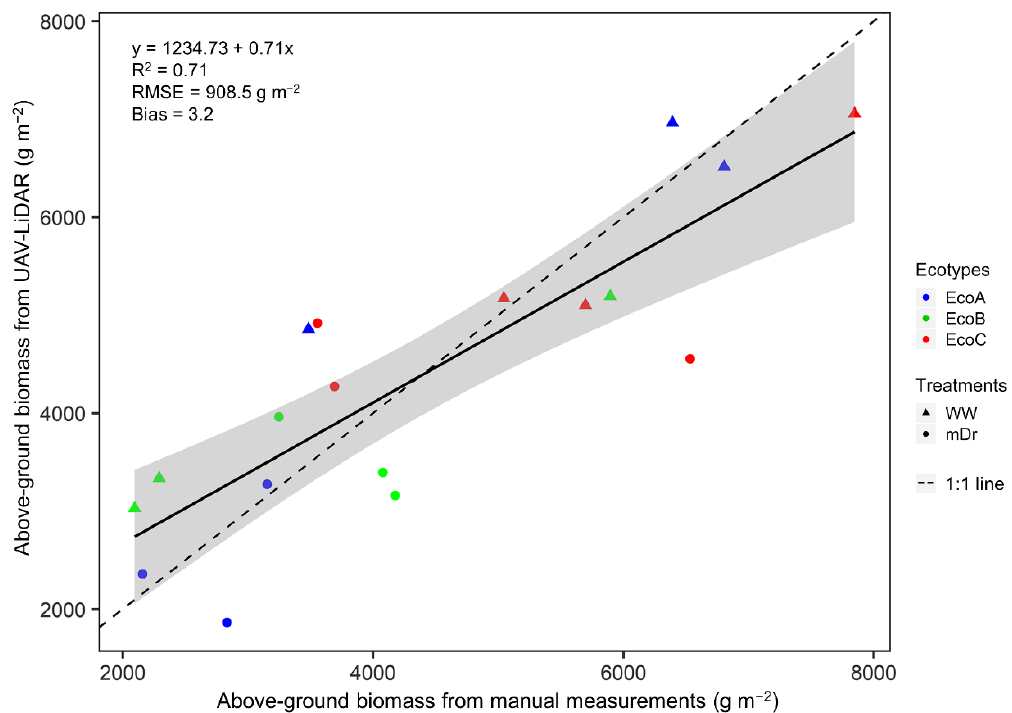
Figure 8. The relationship between the measured above-ground biomass (AGB), and the predicted AGB using unmanned aerial vehicle (UAV)-derived light detection and ranging (LiDAR) data under two water regimes: well-watered (WW) and natural moderate drought (mDr). Grey zone represents confidence interval (95%) of the fitted line. Dashed line is the 1:1 line.